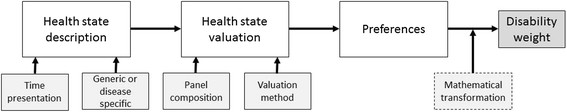
Conceptual model of assessing disability weights and its design choices.